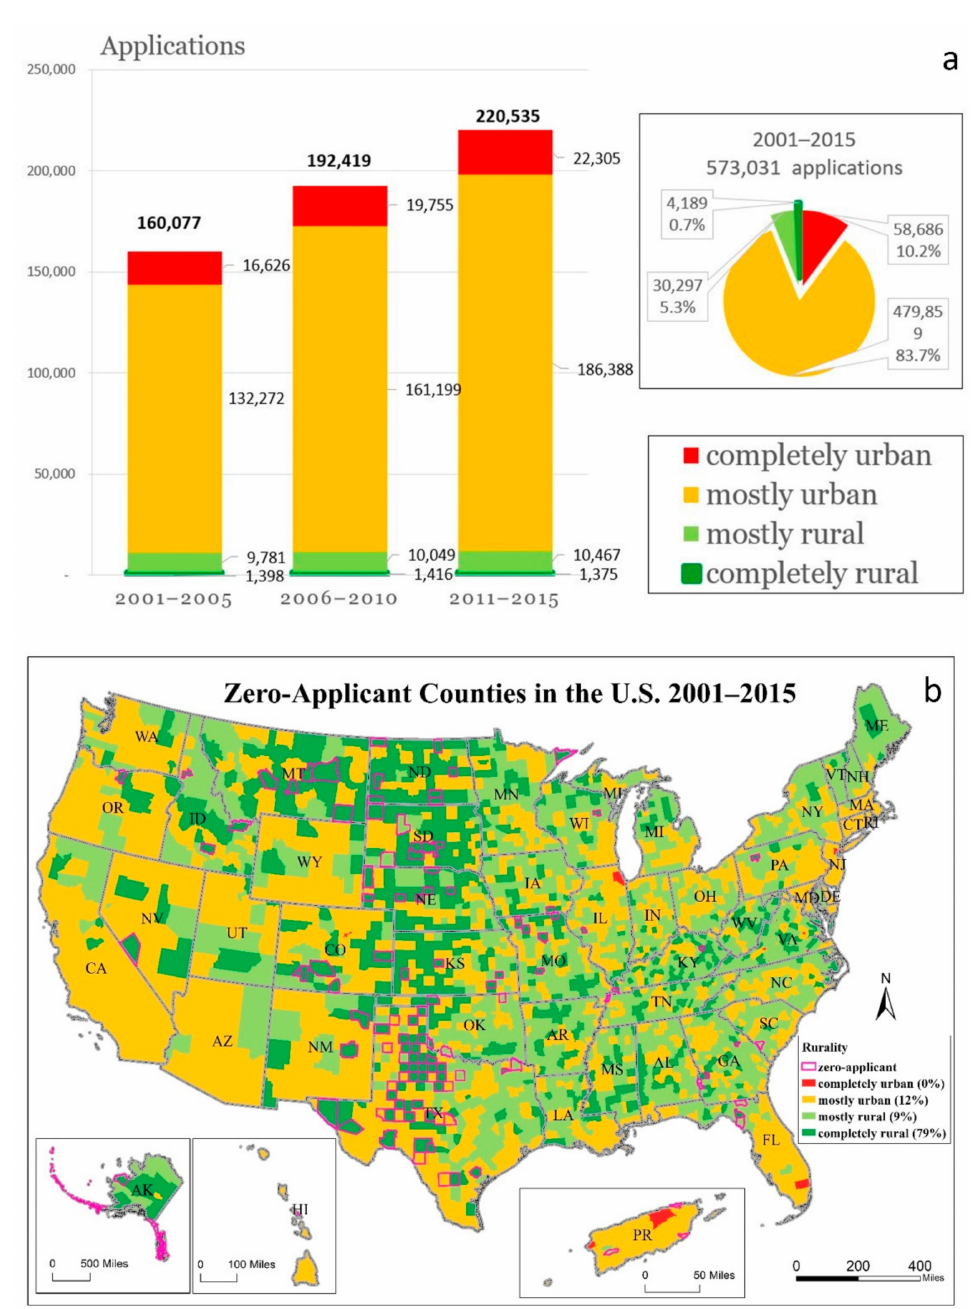
Figure 2. Applications by rurality and zero-application counties (2001–2015), ( a ) total applications by rurality, ( b ) zero-applicant counties in the